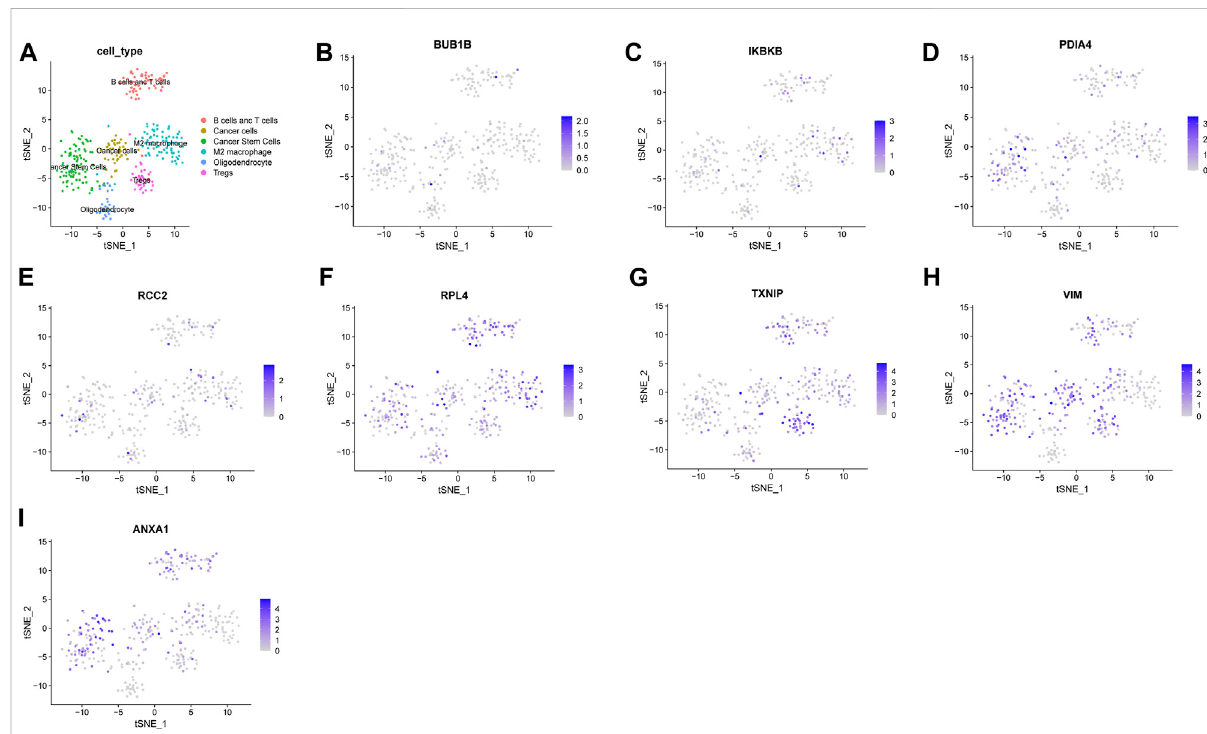
FIGURE 6 Analysis of the CGGA single-cell RNA sequencing database. (A) Annotation of clusters (B – I) Expression of NRDEG signature genes by scRNA- sequencing ( BUB1B , IKBKB , PDIA4 , RCC2 , RPL4 , TXNIP , VIM , and ANXA1